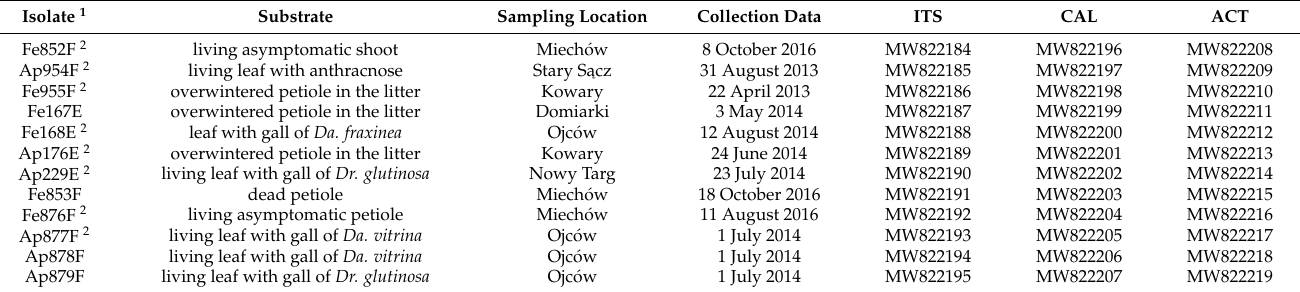
Table 3. Fungal isolates of Apiognomonia hystrix obtained in the present